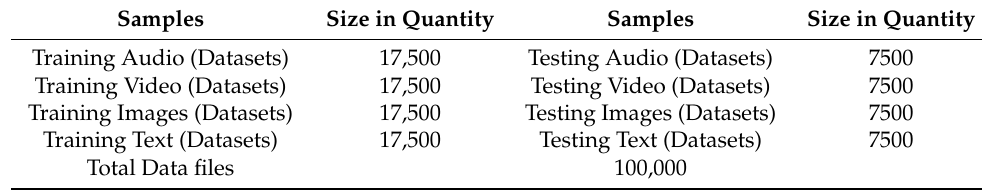
Table 3. Training and Test sets